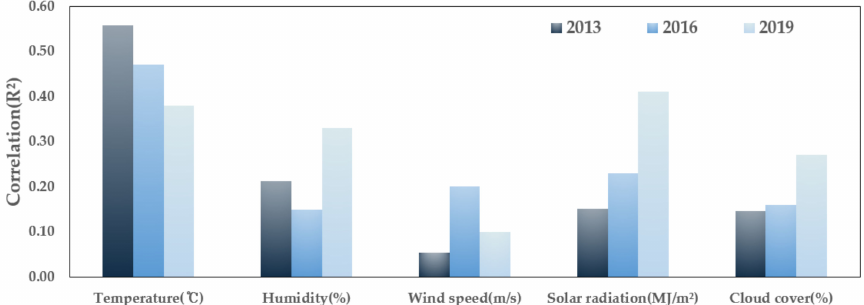
Figure 4. The correlation between electric load and weather factors by